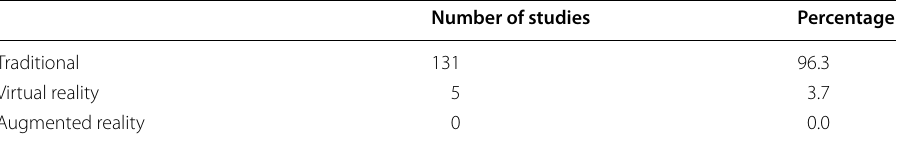
Table 7 Distribution of learning